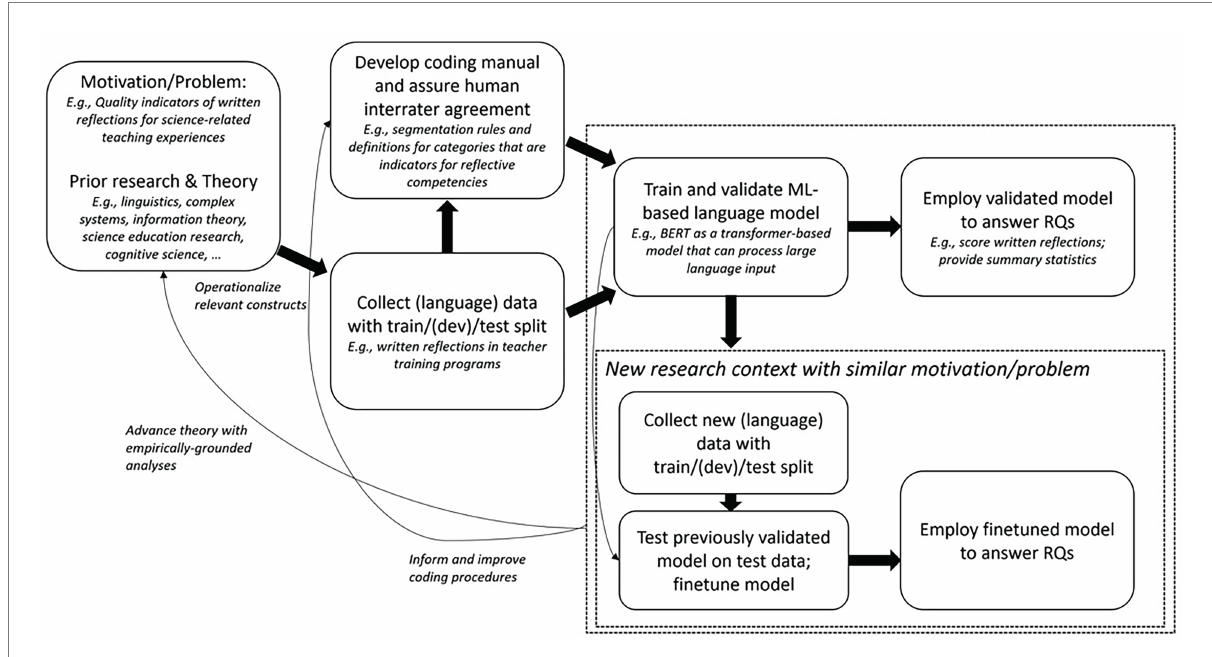
FIGURE 4 Research pipeline to employ and transfer ML-based language